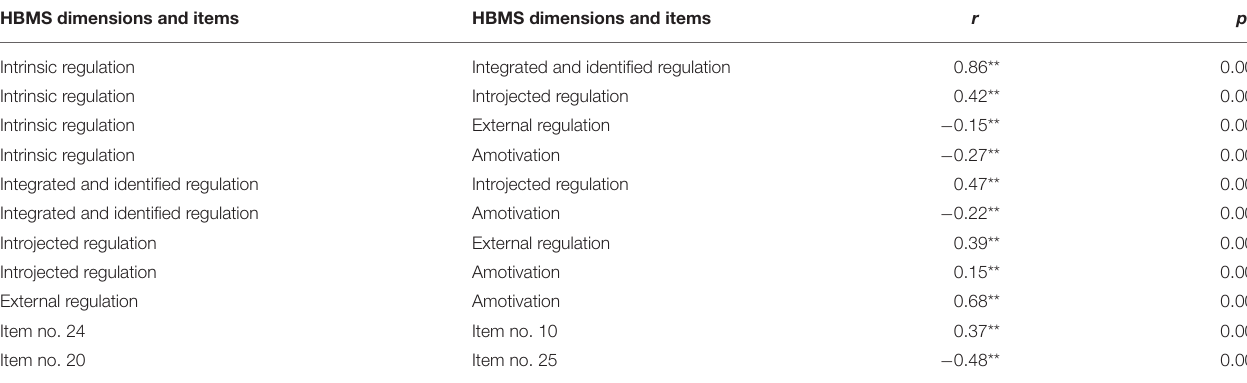
TABLE 5 | Intercorrelations of the health behavior motivation scale (HBMS) dimensions, Study